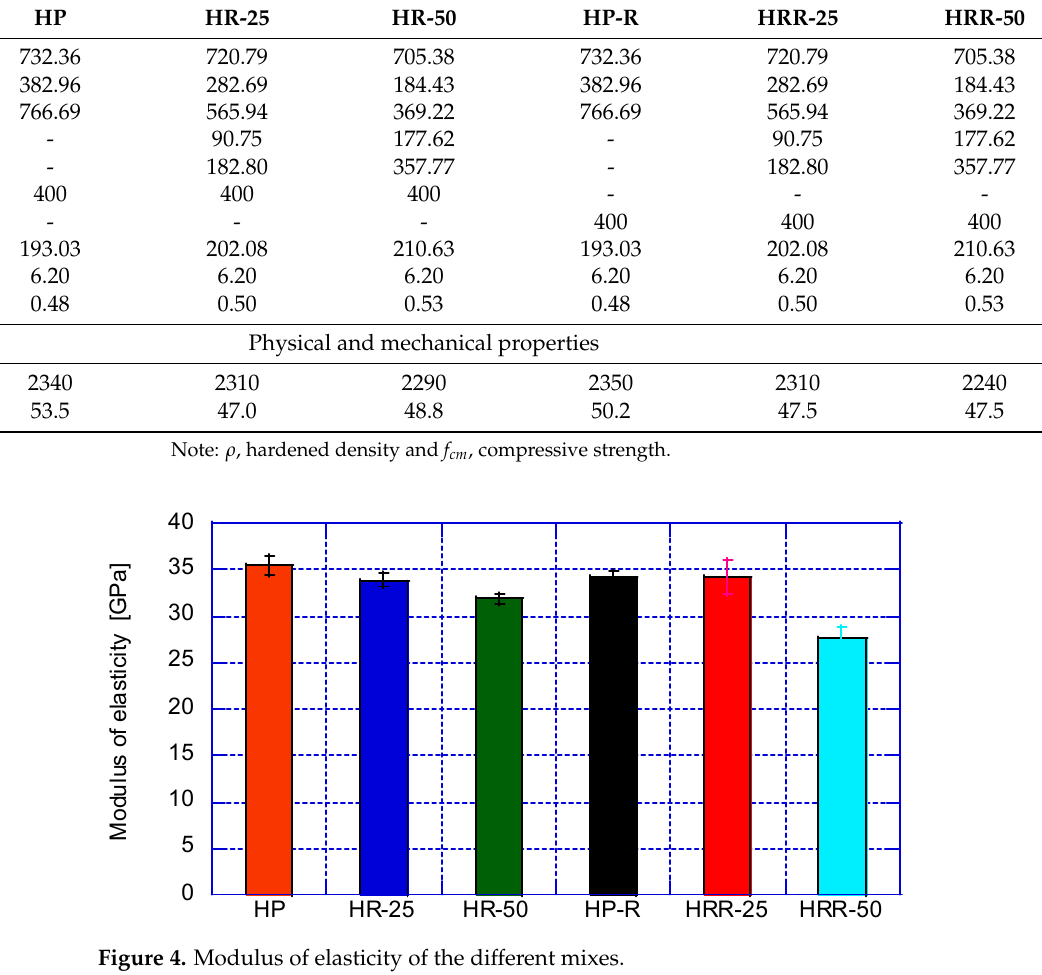
Figure 4. Modulus of elasticity of the different mixes.